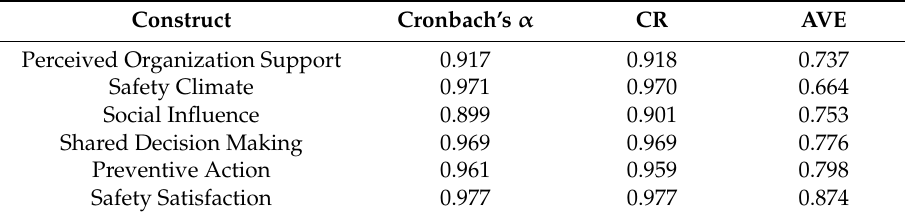
Table 2. Results of reliability and validity analyses.